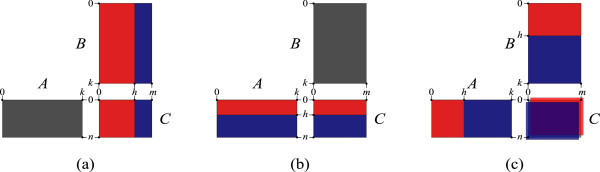
Decomposition of a matrix-multiplication. In all three charts, the matrix C is the result of the multiplication A ⊗ B. Charts (a), (b), and (c) illustrate items 1, 2, and 3 of Observation 1, respectively.